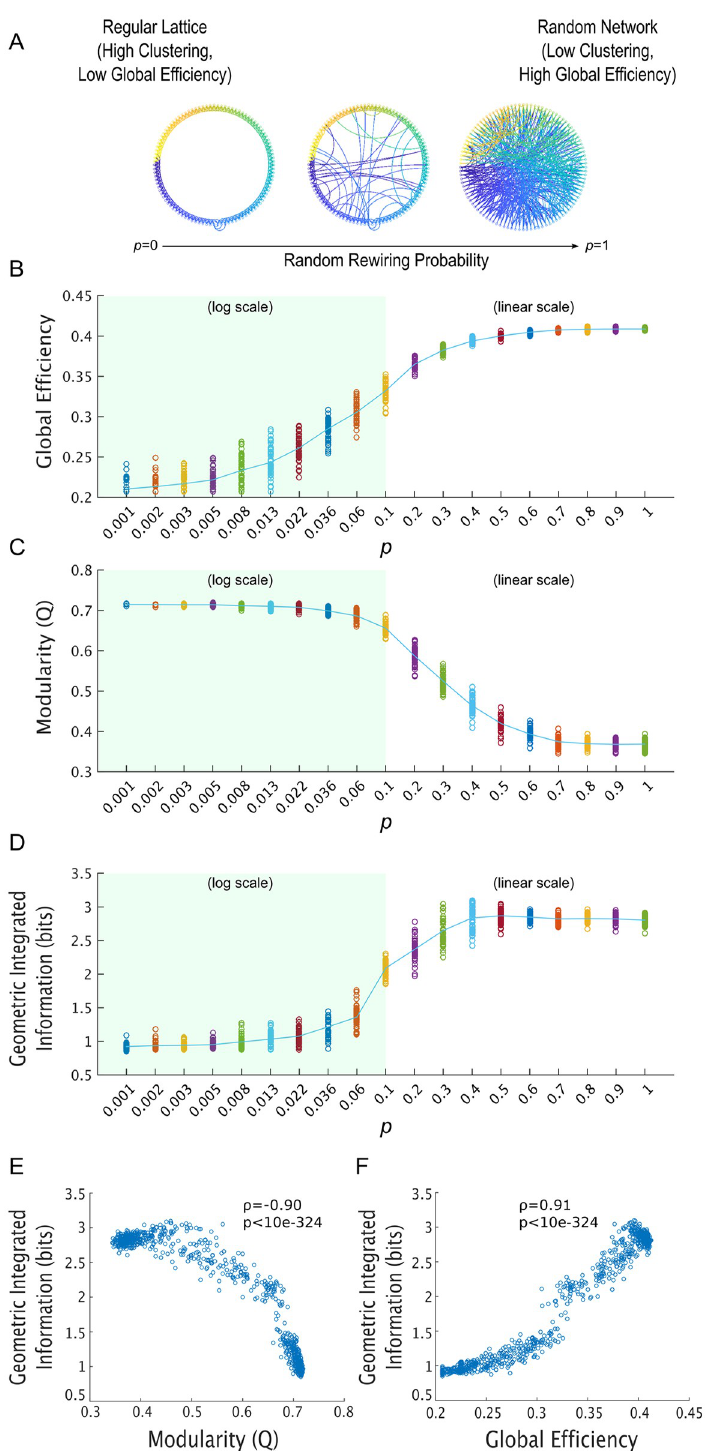
Fig 5. The method presented in this paper for quickly identifying a network’s MIB using spectral clustering makes it possible to quickly measure integrated information in large brain networks. A straightforward first-pass at an application for our method is to evaluate the long-held and untested assumptions that the “global efficiency” of a network reflects its capacity for information integration and that the modularity of a network underpins the segregation of information. A Following the procedure introduced by Watts and Strogatz [53], we